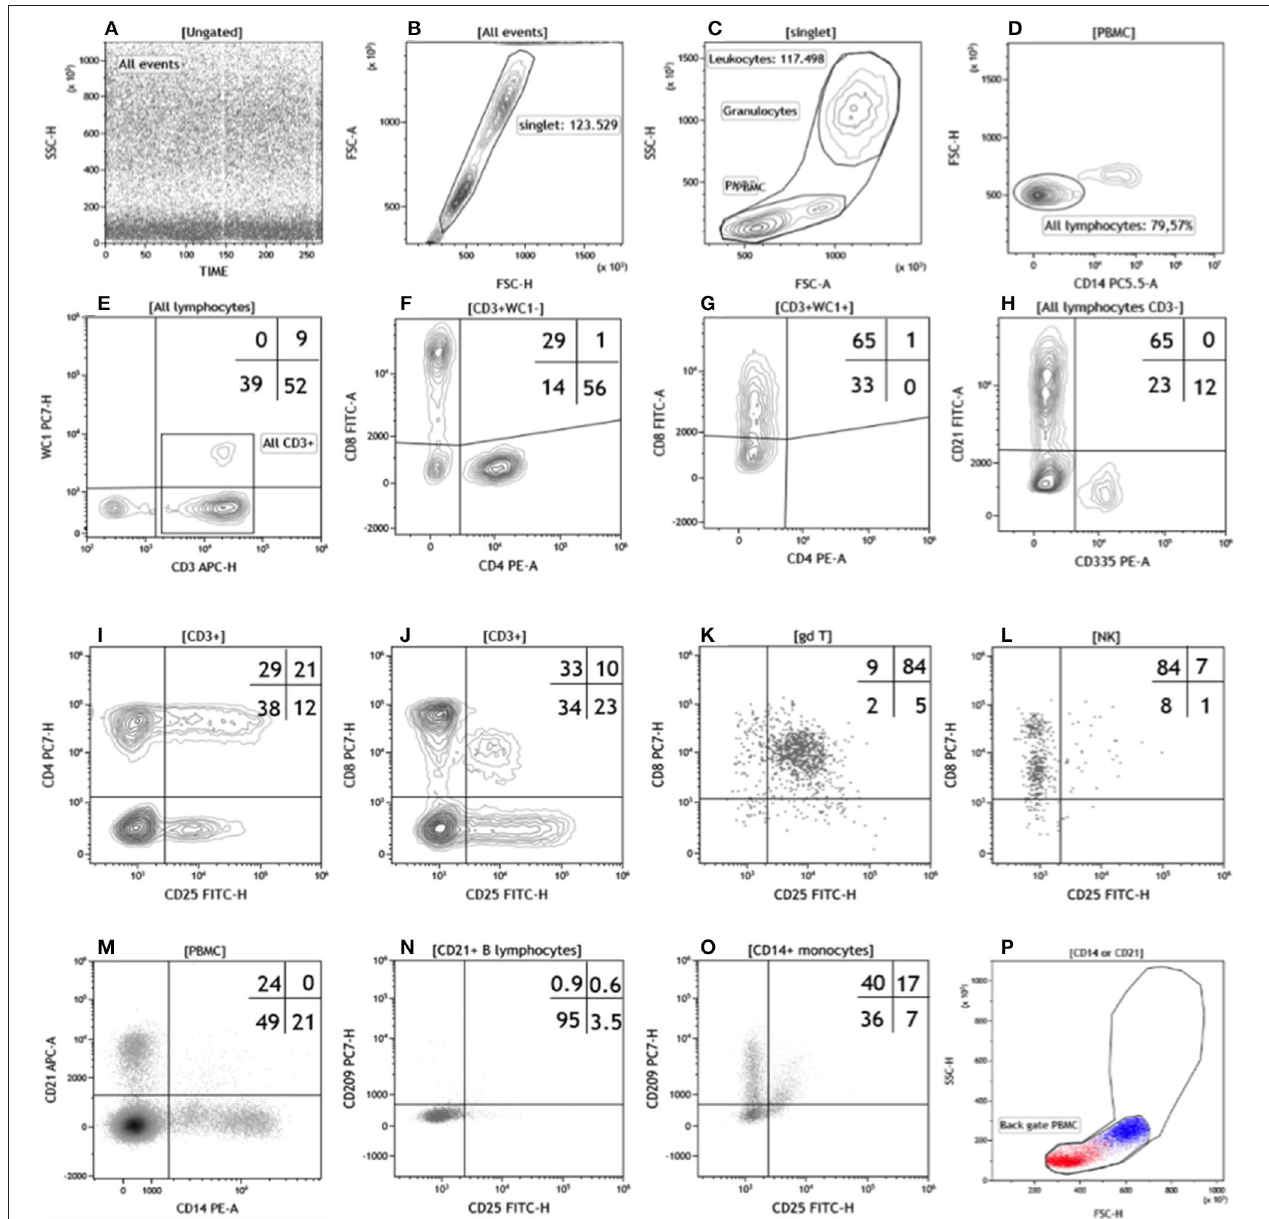
FIGURE 1 | Flow cytometric gating strategy used in this study. The gating strategy (A–H) used to identify the lymphocyte subsets in Trial 1 was: (A) time parameter vs. SSC or FL to exclude event burst, (B) FSC-H vs. FSC-A to exclude doublets, (C) FSC vs. SSC to exclude debris, damaged and/or dead cells, then identify total leukocytes and PBMC, (D) CD14 vs. WC1 to identify total T lymphocytes and the WC1 subset. To characterize the other T lymphocyte subsets we used CD4 vs. CD8 for both WC1 − CD3 + (F) and WC1 + CD3 + (G) T cells. In buffalo the CD8 antigen is expressed by most γδ T lymphocytes (10), then we calculated the absolute value of CD3 + CD8 + ( Table 3 and Supplementary Table 1 ) as the total of upper left quadrant events in (F,G) dot plots. All lymphocytes CD3 − (bottom left in the dot plot E ) were used to identify CD21 + B lymphocytes (top left) and NK cells (CD335 + bottom right) in the (H) dot plot. The gating strategy (I–O) used in Trail 2 had in common the first three gates (not shown) of Trail 1 (A–C) . For Panel 1, a CD3 vs. δ chain CD4 or CD8 dot plots were used to identify T lymphocyte subsets (not shown). In the Panel 2 and 3 we used a CD3 vs. SSC dot plot to identify all CD3 positive lymphocytes while CD3 vs. CD4 or CD8 dot plots to identify CD4 or CD8T